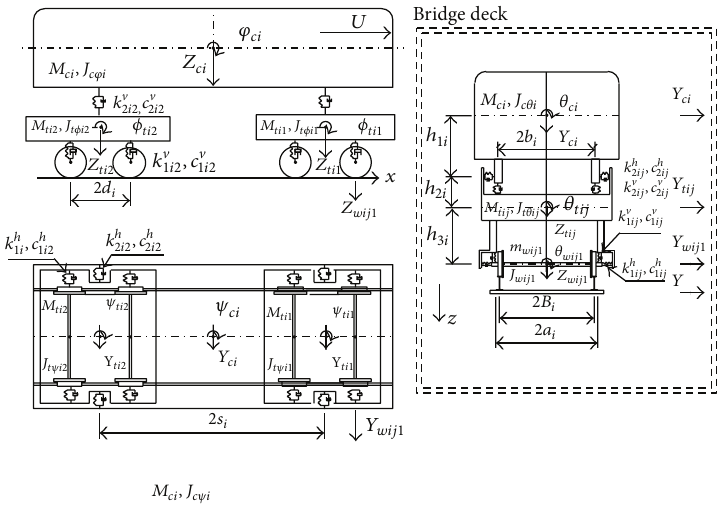
Figure 3: Dynamic model of a railway vehicle